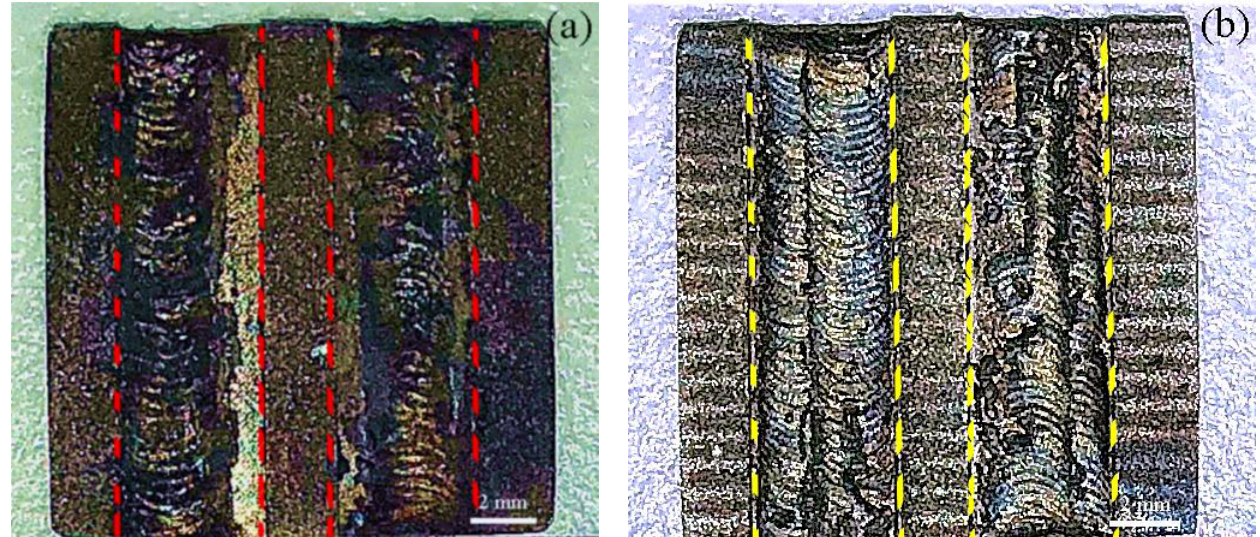
Figure 3. ( a ) A sample with amorphous powder cladding layer. ( b ) A sample with crystalline powder coating.